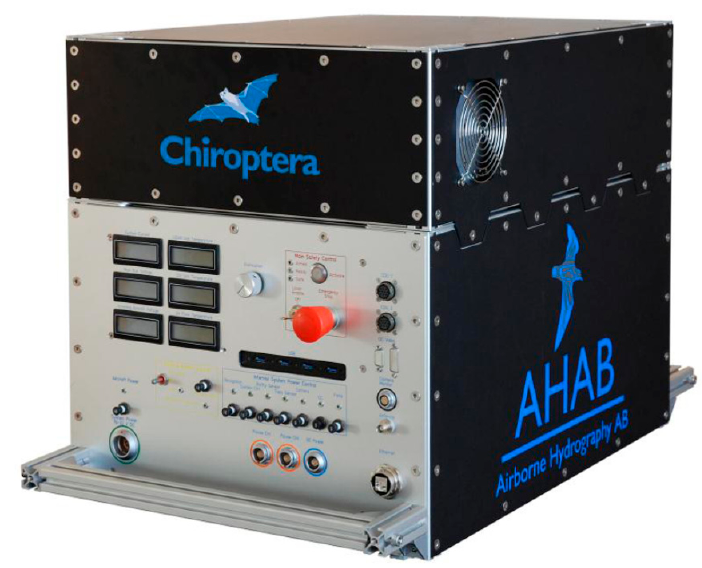
Figure 1. Custom-built Leica AHAB Chiroptera.